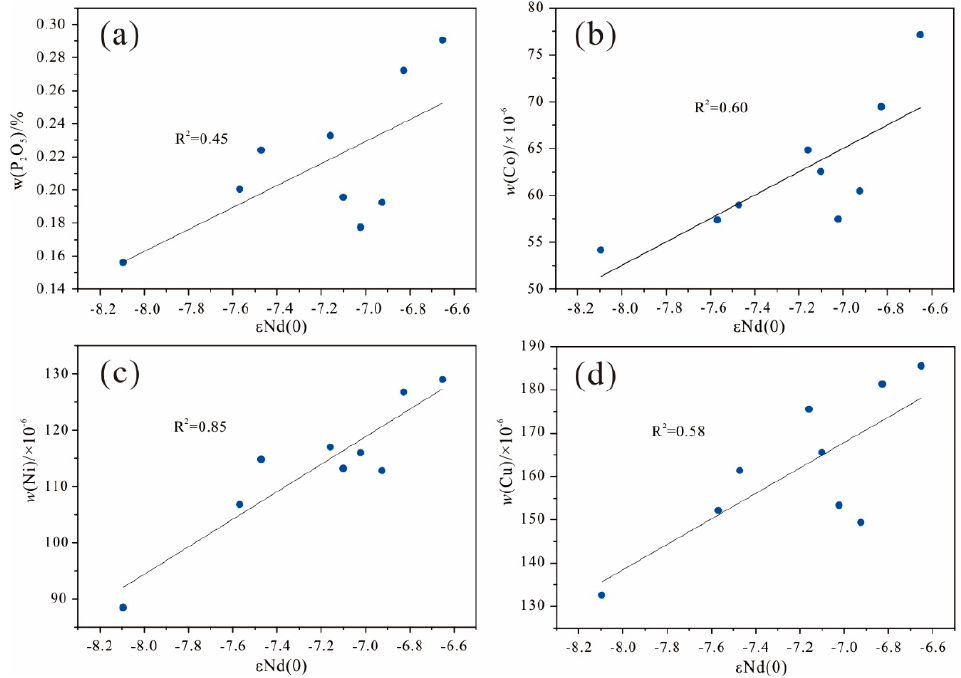
Figure 8. Correlation between ε Nd(0) and P 2 O 5 ( a ), Co( b ), Ni( c ), Cu( d ) in CG1601. Note that concentrations of major and trace elements were measured per 2cm while ε Nd(0) was measured per 10 cm, in order to compare with ε Nd(0) of the same depths, 5 points average of those concentrations (major and trace elements) were calculated with 10 cm interval through the core.